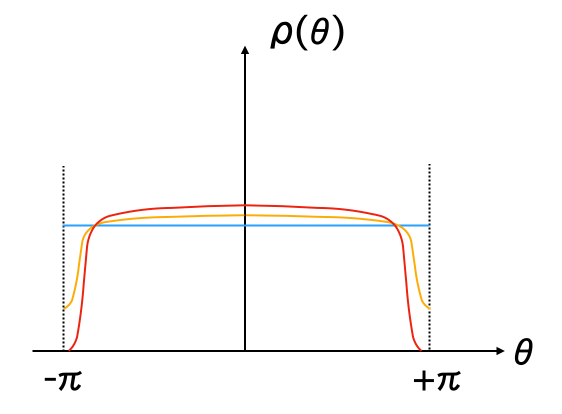
Figure 8. Possible form of the phase distribution around the phase transition at very small µ